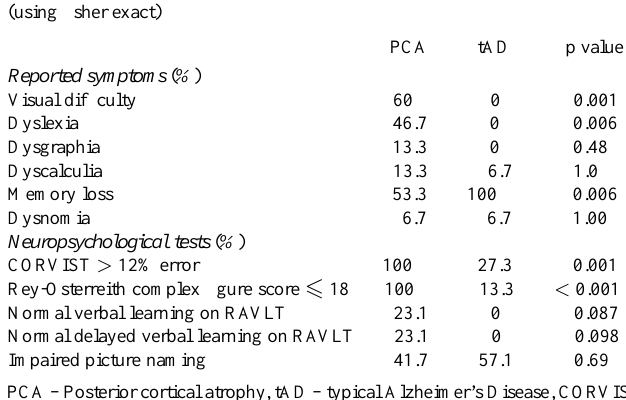
Table 2 Comparisons of dichotomous scores and symptoms for PCA versus tAD